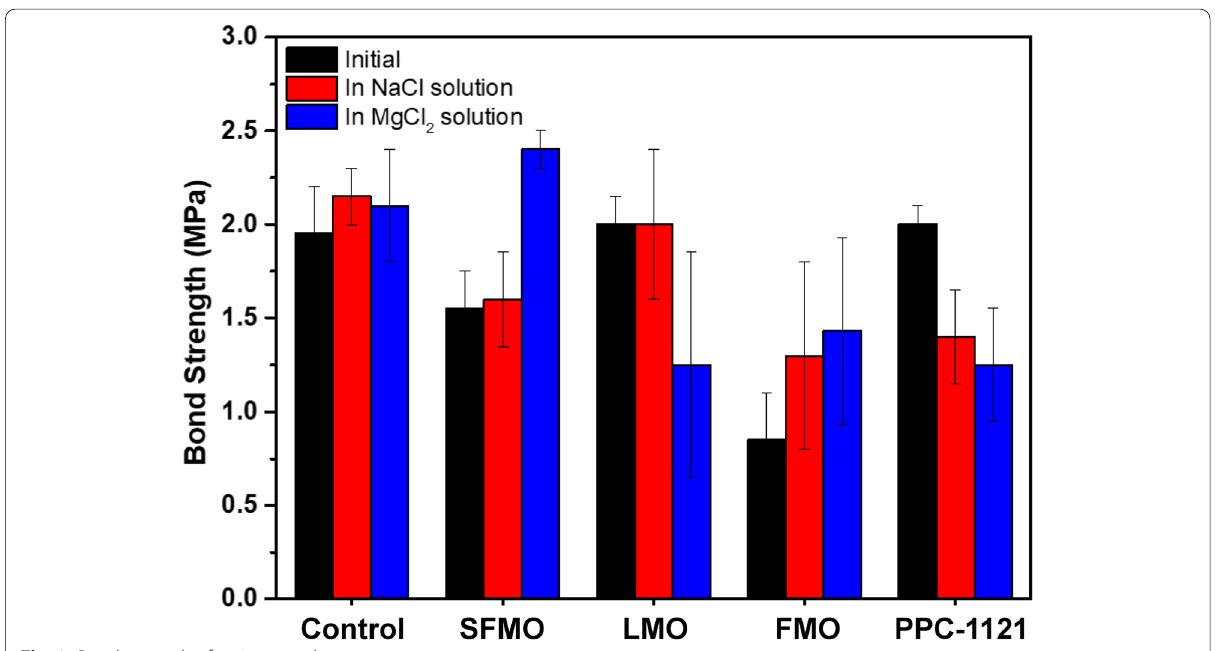
Fig. 2 Bond strength of various